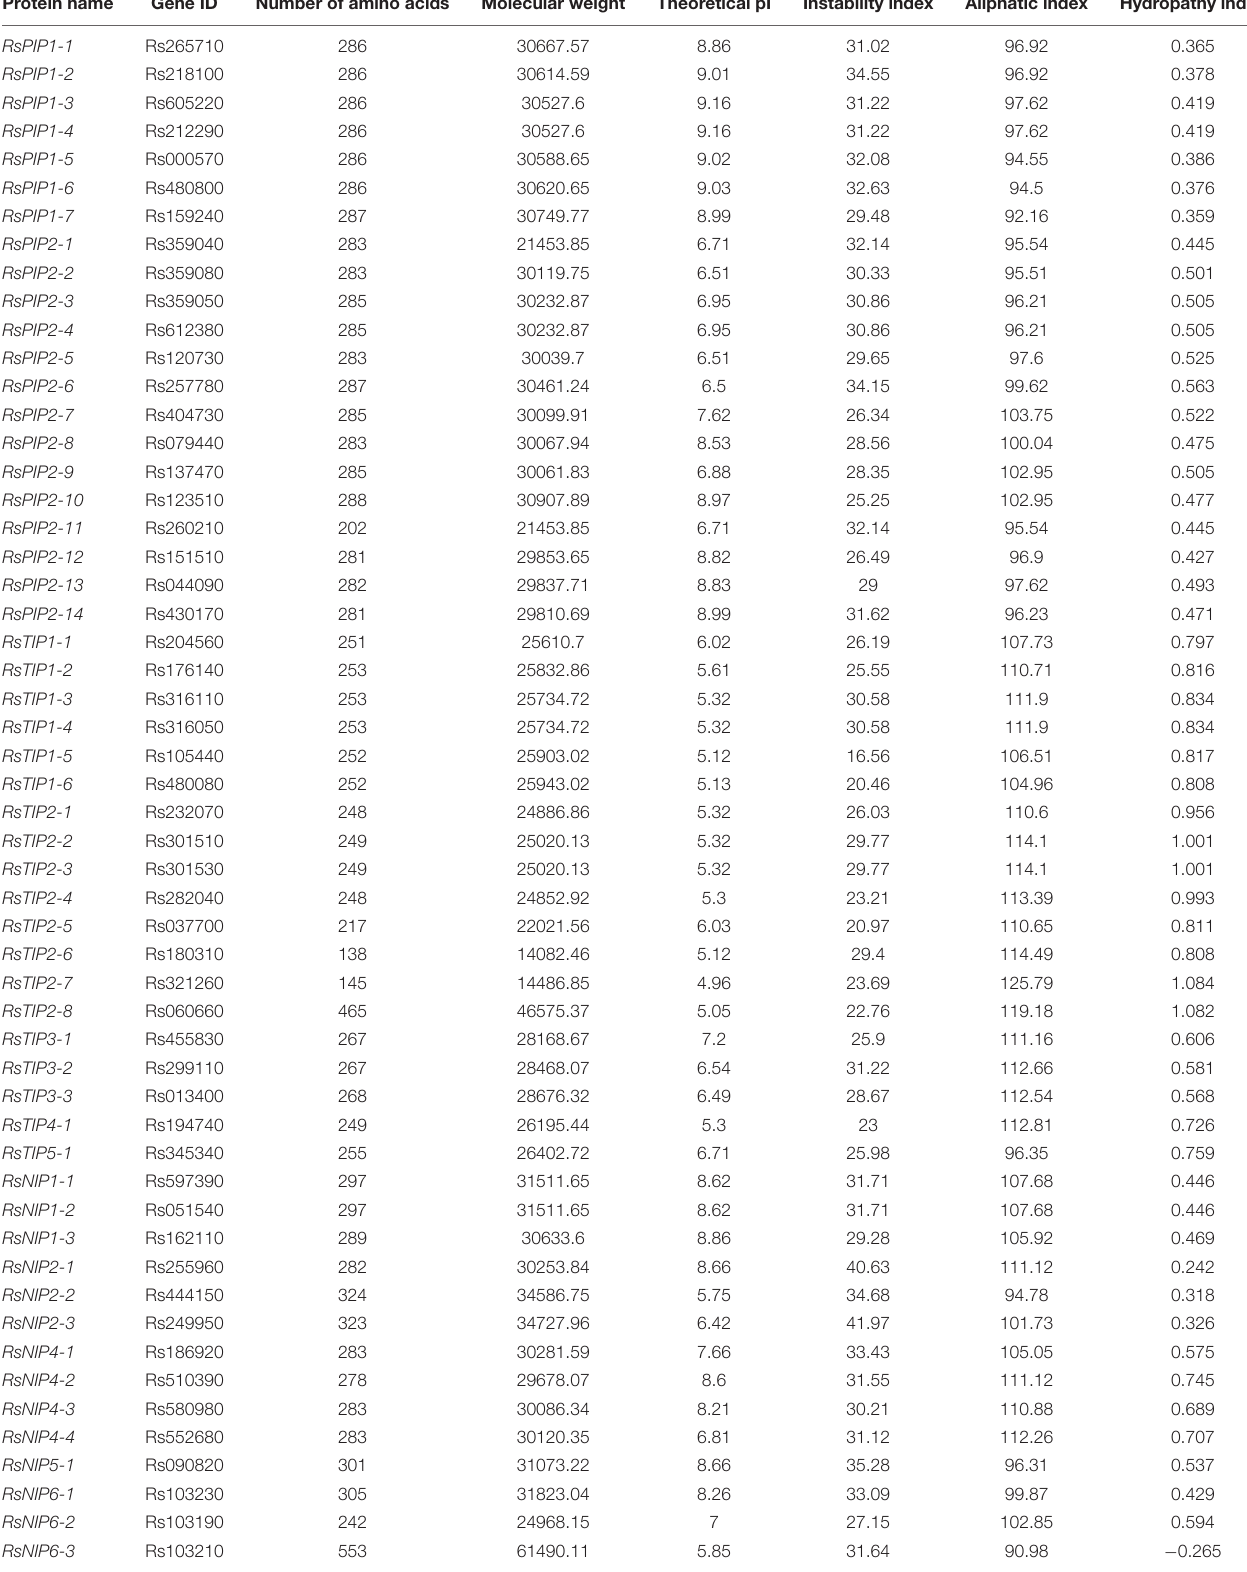
TABLE 1 | Identification and characterization of AQP proteins in